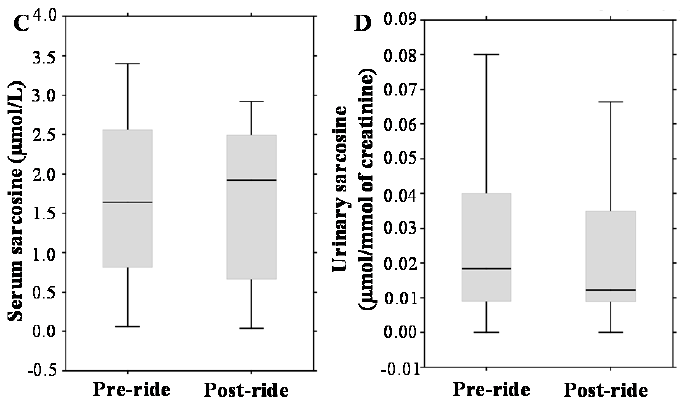
Figure 3. Effect of physical exercise on biomarkers of prostate cancer (PCa), expressed as box plots for: ( A ) serum total prostate-specific antigen (tPSA); ( B ) serum free PSA (fPSA); ( C ) serum sarcosine; and ( D ) urinary sarcosine. The middle lines in the figures indicate the median values.